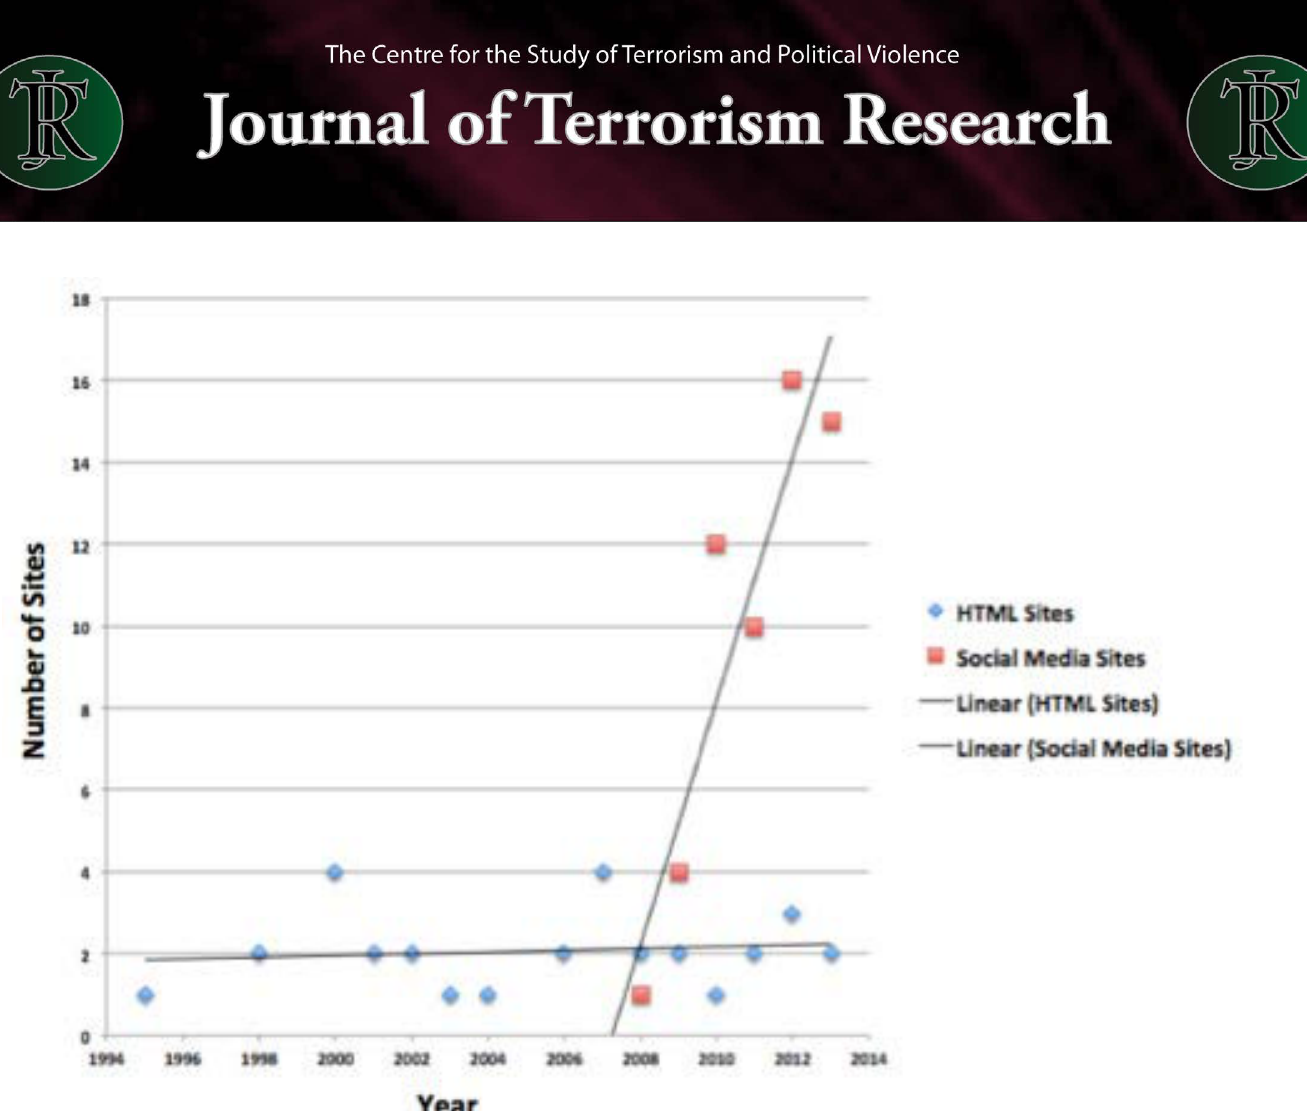
Figure 7: Number of HTML and Social Media sites created from 1994 to